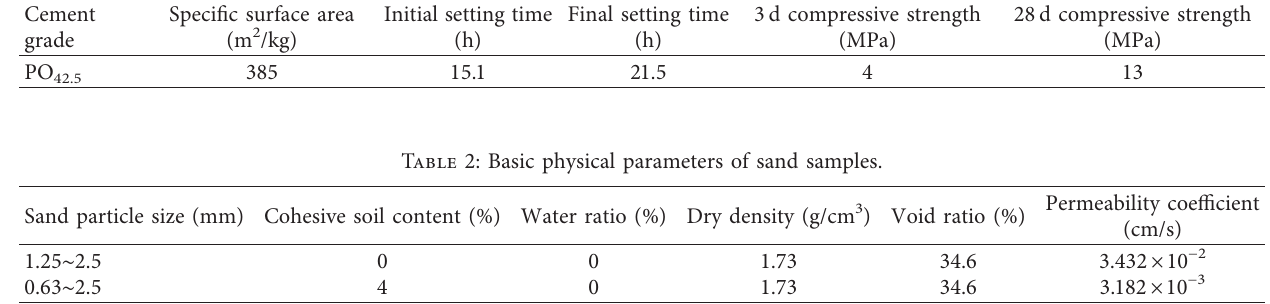
Table 1: Basic physical and mechanical properties of cement in test. Cement